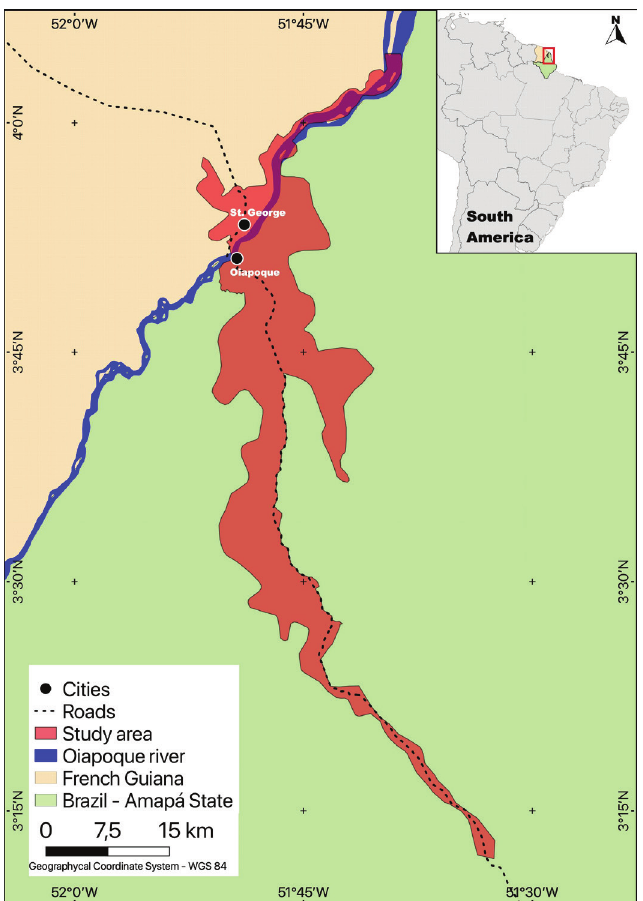
Figure 1: Location of the study area